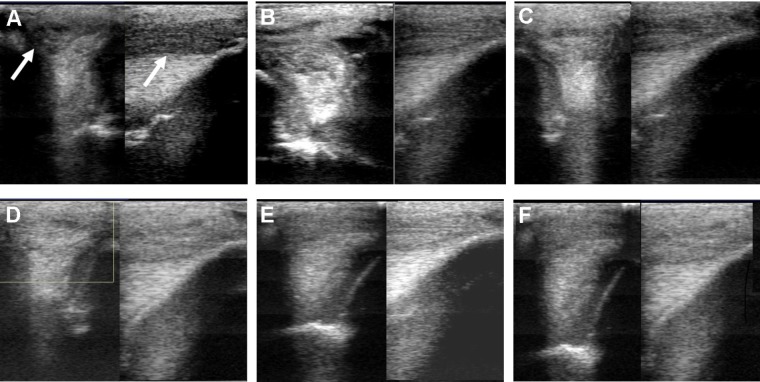
Ultrasound images prior to plasmid DNA encoding VEGF164 and FGF2 genes on day 0 (A), 20 (B), 40 (C), 90 (D), 180 (E), and 300 (F) after administration in horse #2 – SLB desmopathy. Arrows indicate lesion.